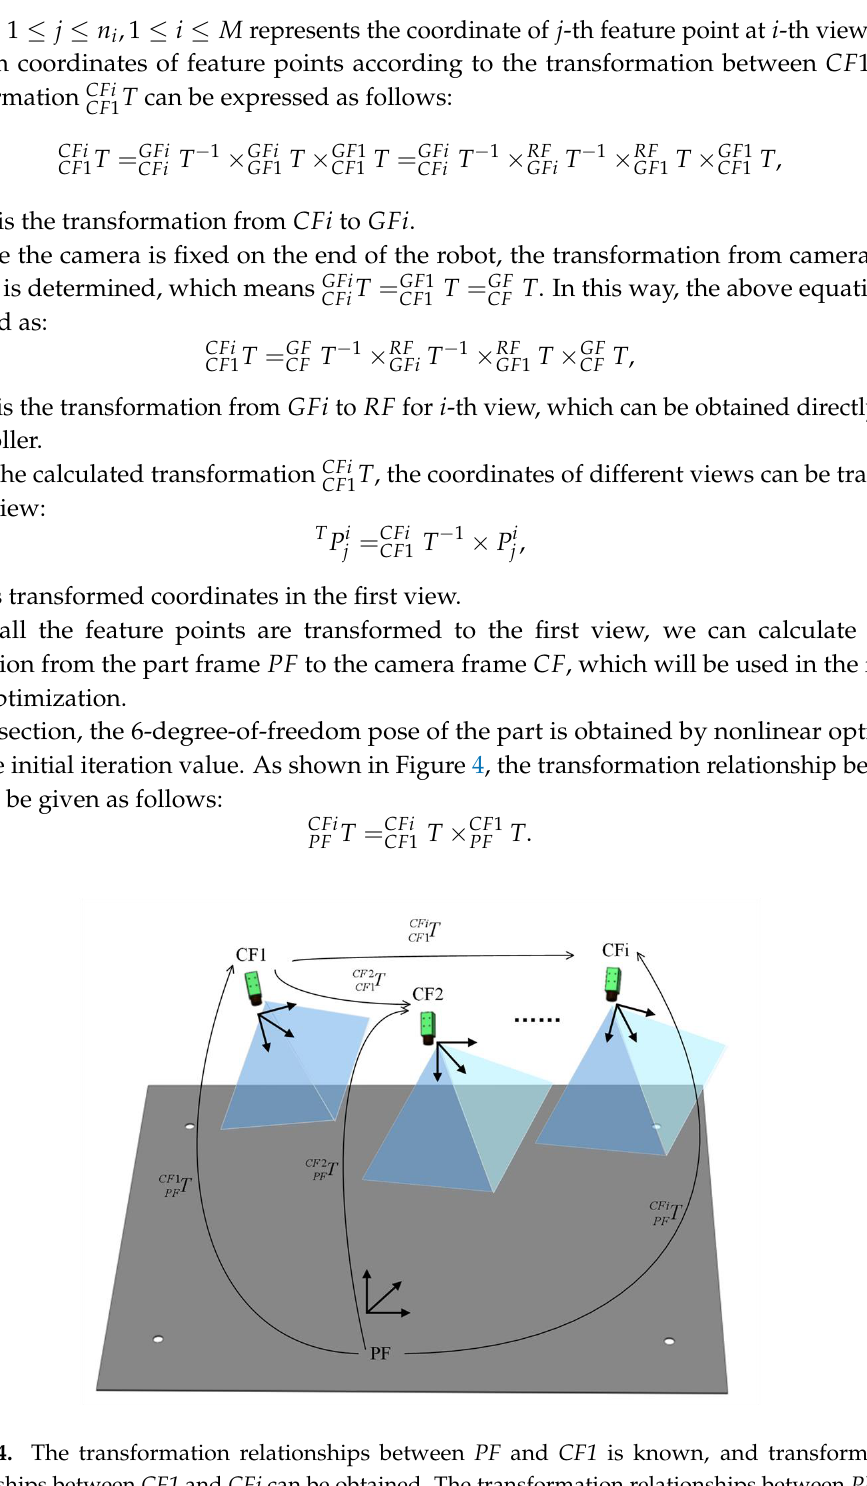
Figure 4. The transformation relationships between PF and CF1 is known, and transformation relationships between CF1 and CFi can be obtained. The transformation relationships between PF and CFi can be